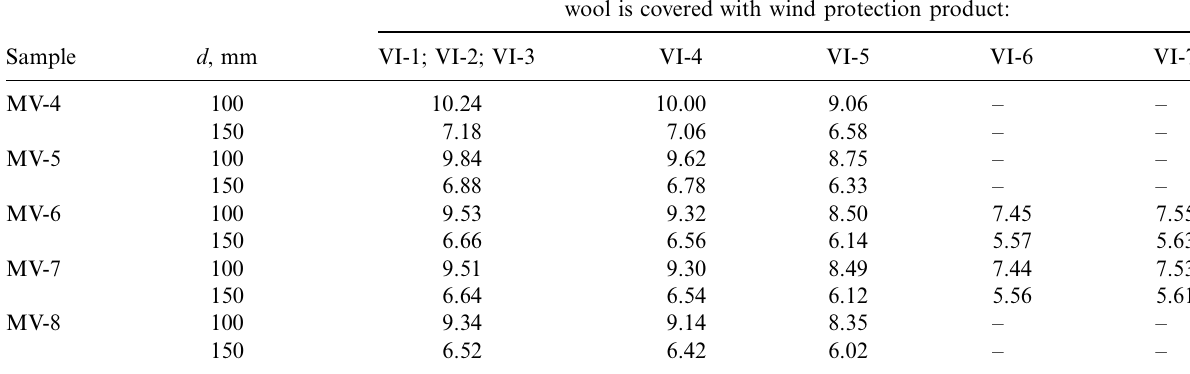
Table 4. The calculated average heat flow density values of the non-ventilated wall under air temperatures u e (cid:2) (cid:5) 10.0 8